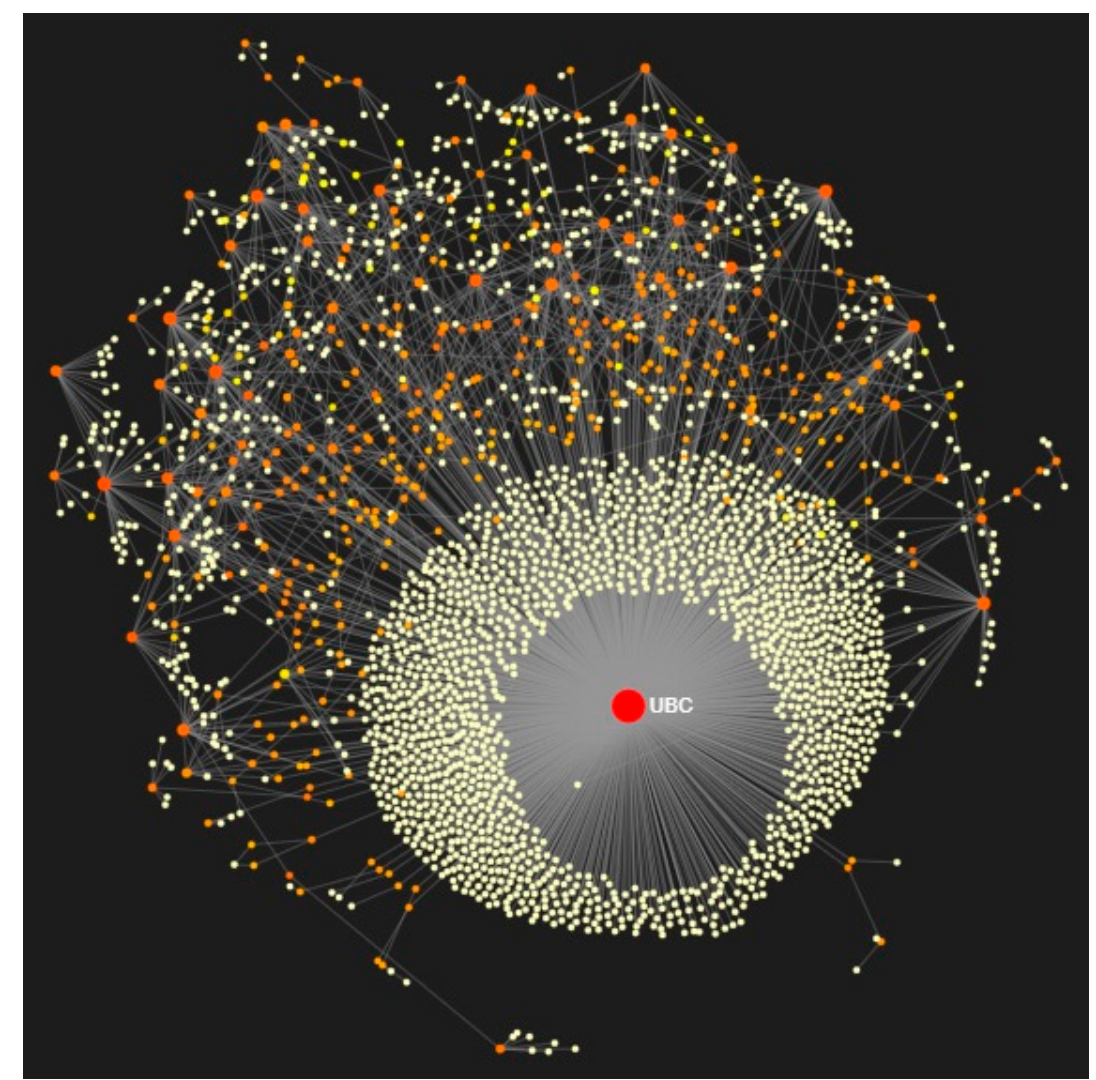
Figure 3. Protein–protein interaction (PPI) network of overlapping genes of miR-1246 targets and differentially expressed circulating mRNAs in force atlas layout (red color indicates downregulated genes, orange color indicates upregulated genes, and yellow color indicates interconnected genes). Change in the size of the nodes depends on degree centrality measures. UBC is the major node of the subnetwork that is enriched in ubiquitin-mediated proteolysis.